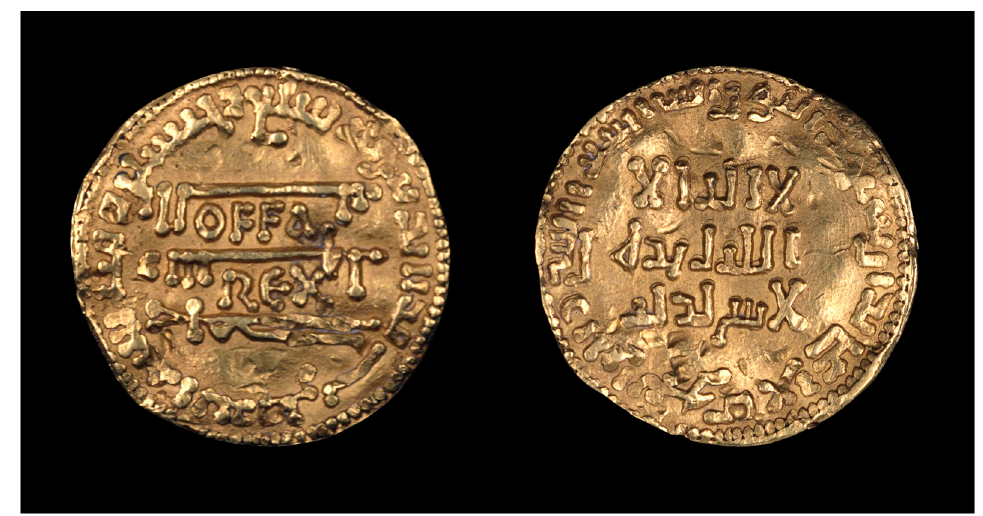
Figure 2. Offa imitation Dinar of Offa © Trustees of the British Museum (CC BY-NC-SA 4.0 license).